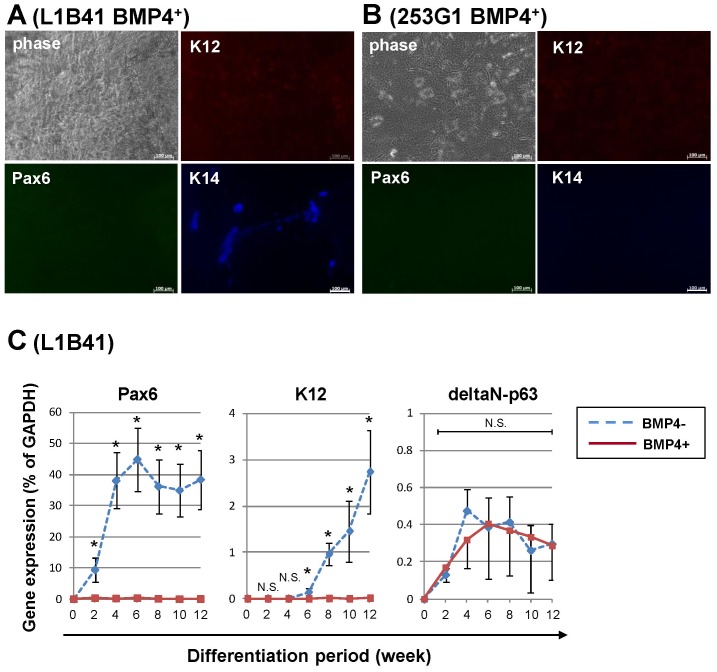
The effect of BMP4 treatment on iPS cells during corneal epithelial differentiation by the SDIA method.(A, B) 0.5 µM BMP4 was added during the first 2 weeks of differentiation by the SDIA method. Triple immunostaining showed that BMP4 treatment inhibited corneal epithelial induction from both iPS cell lines (K12: red, Pax6: green, K14: blue). (C) Real-time RT-PCR showed that Pax6 and K12 expression was completely suppressed by BMP4 treatment in L1B41 iPS cells. In contrast, BMP4 showed no significant effect on delta-N p63 expression. The graph showed the mean ± S.E. of 3–7 independent samples, respectively. *p<0.05 (BMP4− vs. BMP4+, Mann-Whitney rank-sum test), N.S. = not significant. Scale bar: 100 µm.